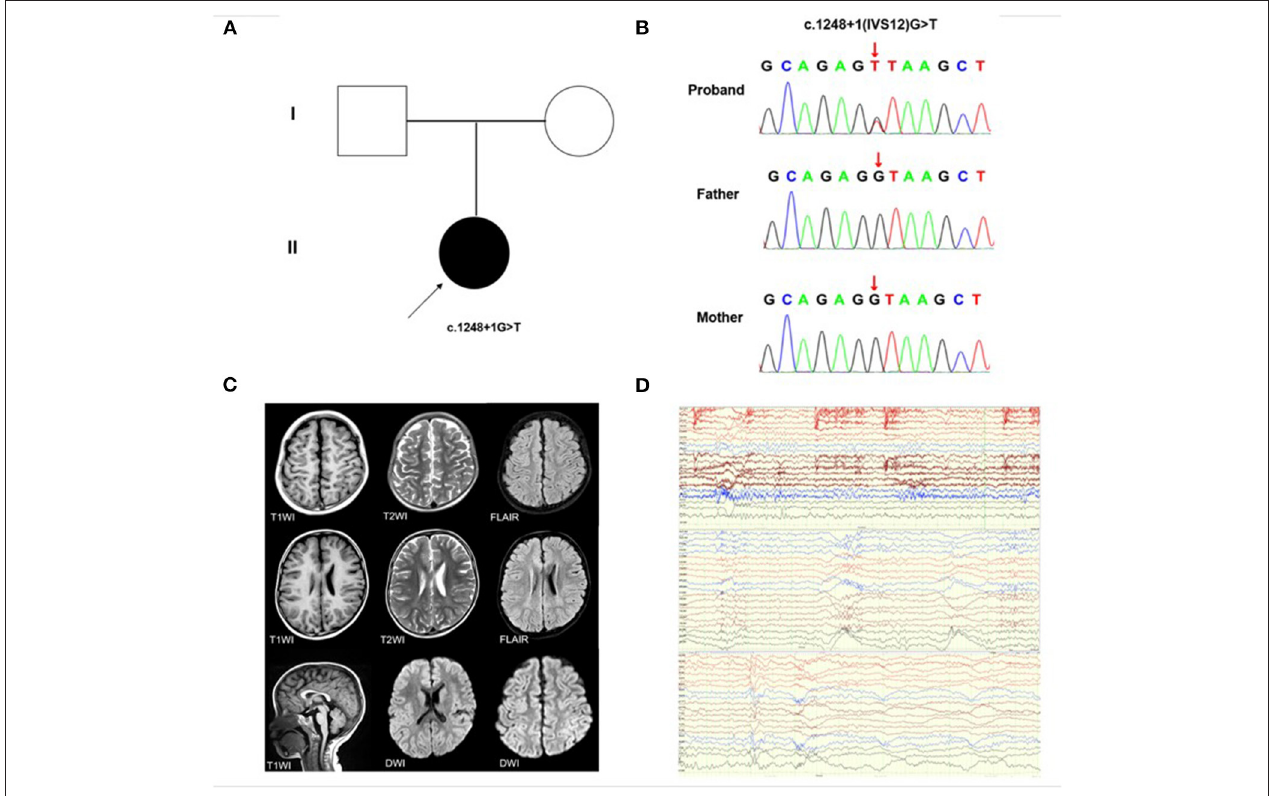
FIGURE 1 | KMT2E gene variant and auxiliary examination of the patient. (A) Schematic presentation of the familial pedigrees. Males and females are designated by squares and circles, respectively. The shapes filled with shadow indicate affected individuals with the KMT2E variant; the arrow indicates the proband. (B) Direct sequencing identified the novel KMT2E (c.1248 + 1G > T) variant (C) Brain MRI of the patient showing delayed myelination (D) The EEG reports of the patients, from top to bottom, representing the background slow wave, general fast wave rhythm during sleep, and general fast wave rhythm during the waking